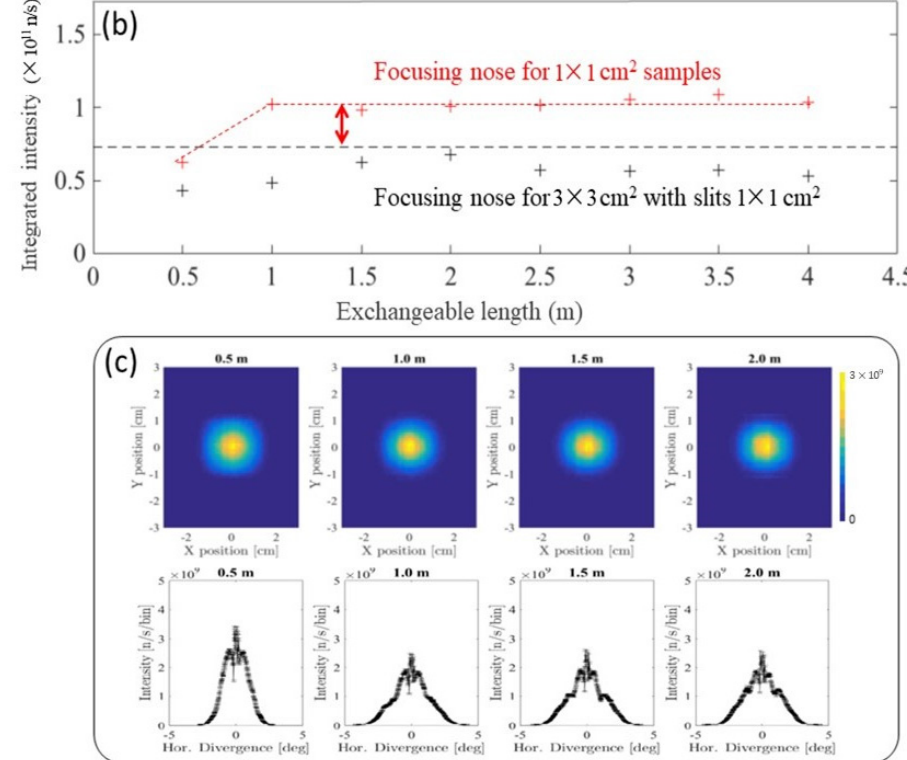
Figure 10. ( a ) Schematic image illustrating the exchangeable focusing guide concept; ( b ) Integrated intensity at sample position using a focusing guide for 3 × 3 cm 2 beam spot with slits aperture of 1 × 1 cm 2 (black dots), compared with the intensity using an exchangeable focusing nose with variable length for 1 × 1 cm 2 beam spot ( red dots ); ( c ) Beamspots ( spatial distributions ) and horizontal divergence distributions at the sample position for different exchangeable focusing guide lengths (from 0.5 to 2 m). The vertical divergence distributions are not shown since the profile is similar to the horizontal counterparts.